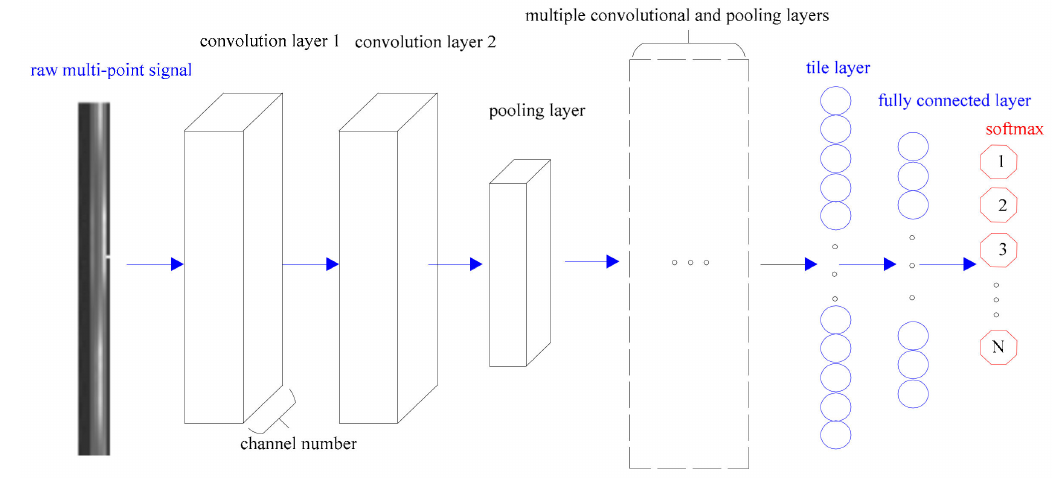
Figure 7. Reciprocating compressor valve fault diagnosis model of the 2-D CNN multi-measurement